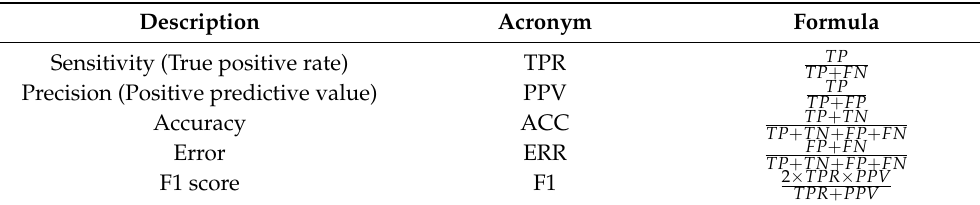
Figure 12. Bar graphs presenting the changes in values and parameters over time calculated from the confusion matrix. Table 6. Selected accuracy indicators calculated for each time period